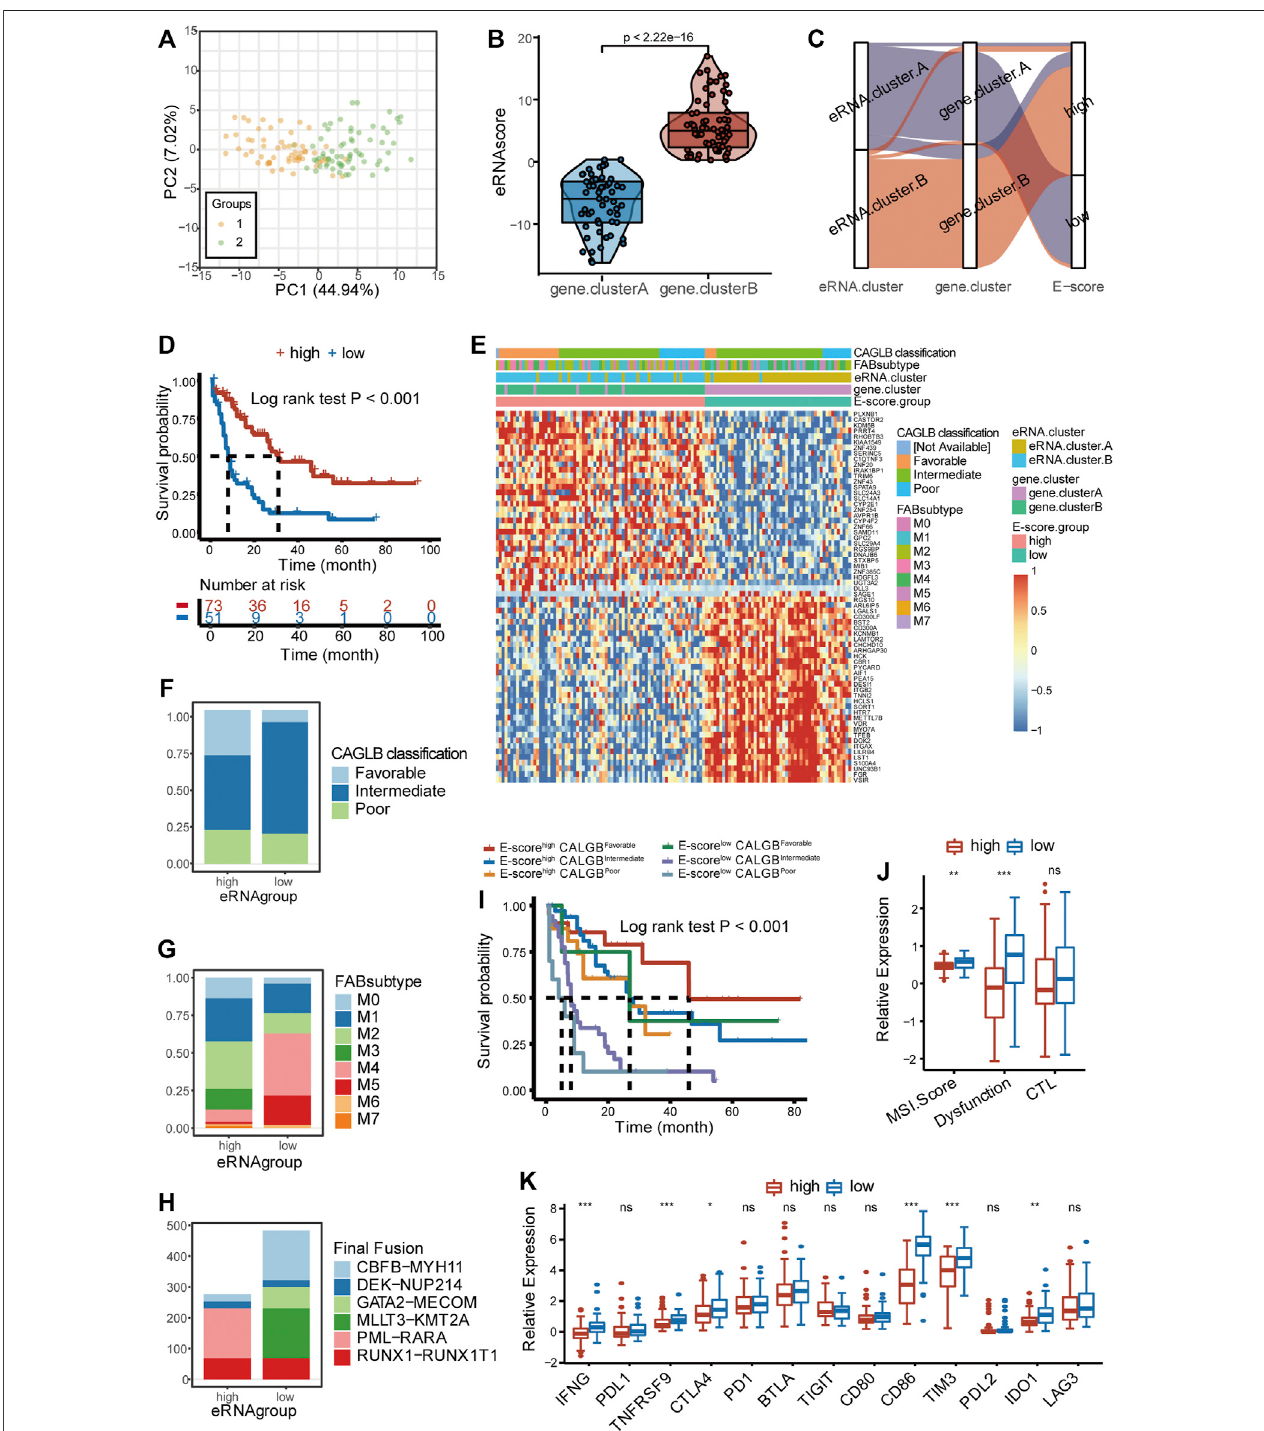
FIGURE6| Clinicalclassi fi cationwitheRNAandpredictionofresponsetoimmunotherapy. (A) Principalcomponentanalysisshoweddistinguished characteristics between the two gene clusters determined by 66 signature genes. (B) Two gene clusters showed distinct eRNA-derived score (E-score) (Wilcoxon test, p < 2.22 × 10 − 16 ). (C) Strati fi cations according to eRNA clustering, gene clustering, and E-score, as well as the correlation among the three strati fi cations. (D) Survival analysis showed different survival outcomes between two E-score groups (log-rank test p < 0.001). (E) Gene expression heatmap and clinical characteristics (CAGLB risk classi fi cation, FAB classi fi cations) in high- and low-E-score groups. (F) Distribution of CAGLB risk classi fi cation groups (favorable, intermediate, and poor) in high- and low-E-score groups. (G) Distribution of FAB subtypes (M0 – M7) in high- and low-E-score groups. (H) Distribution of fusion types in high- and low-E-score groups.